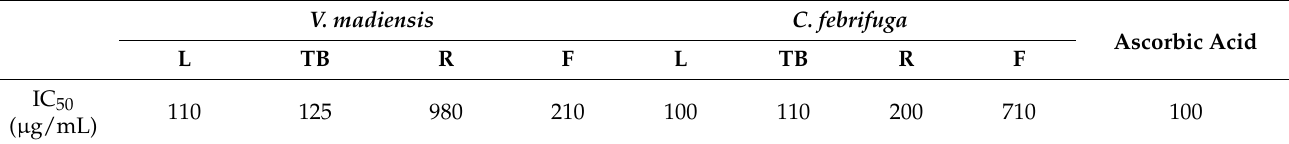
Table 3. Inhibitory concentrations (IC 50 s) of extracts.